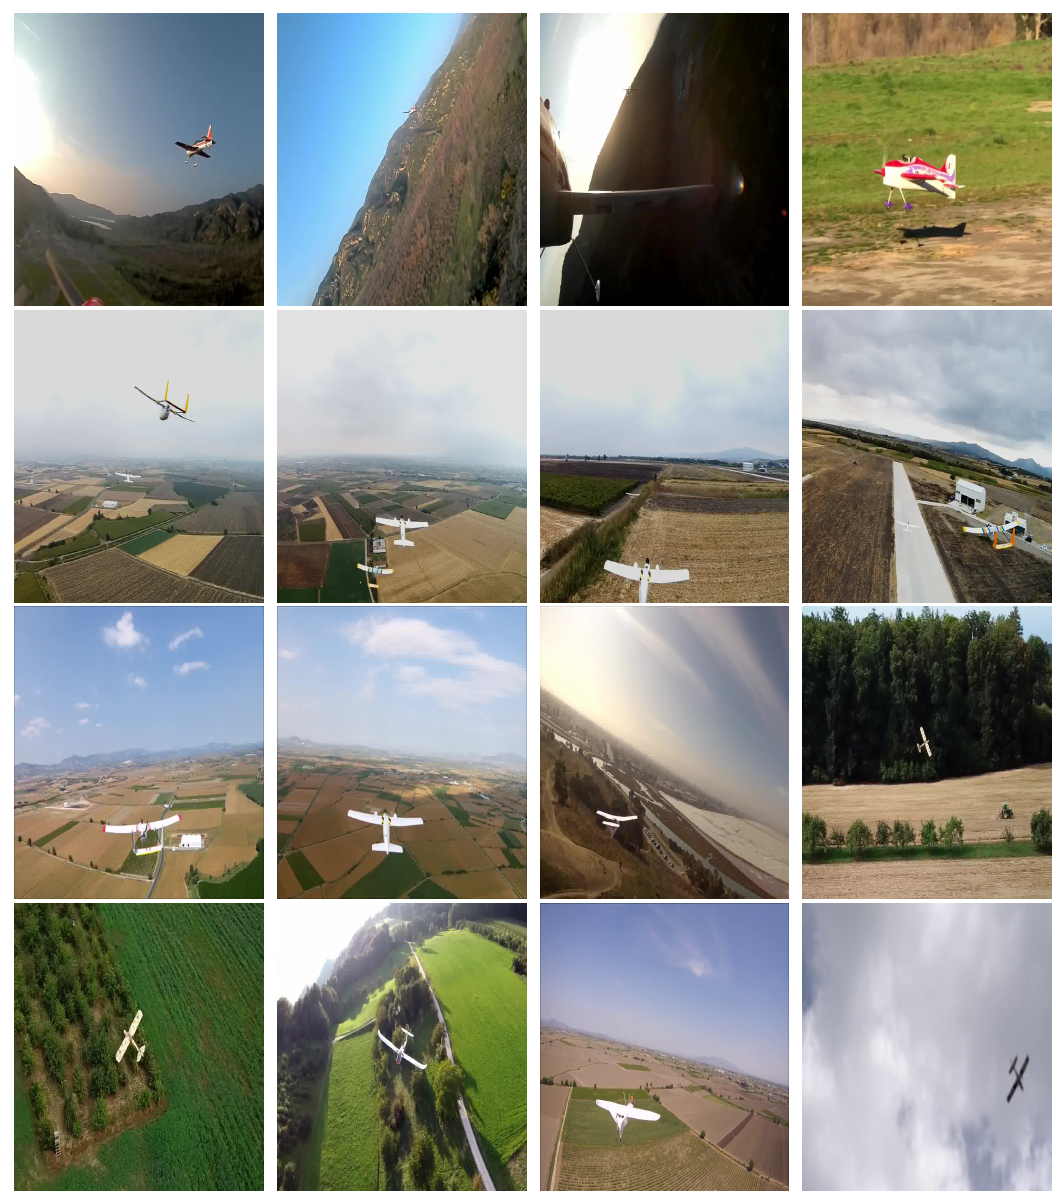
Figure 3. Example UAV images from different videos captured by airborne optic camera. These images show the characteristics and complexity of training and testing